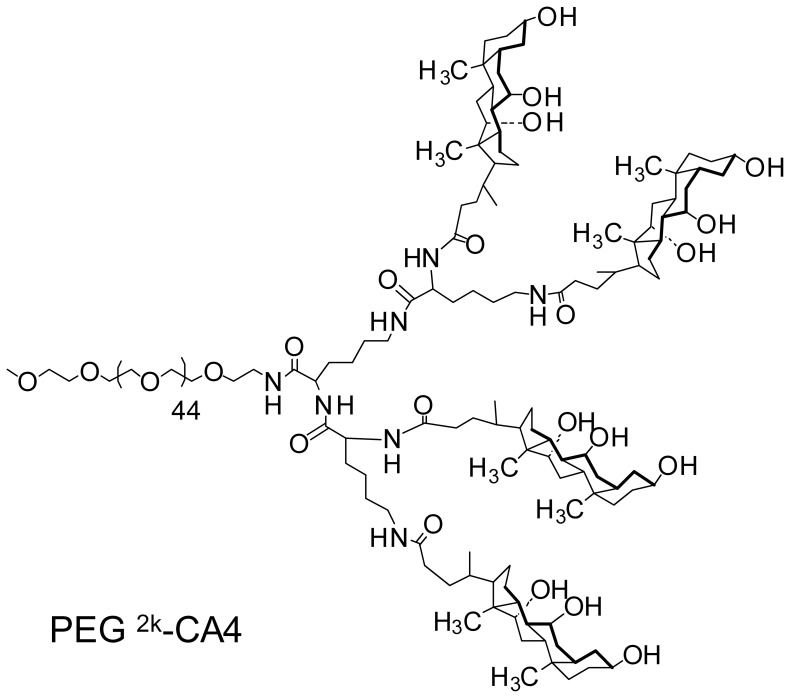
Diagram of PEG2k-CA4 telodendrimer.Boc-NH-PEG2k-CA4 telodendrimer was first synthesized using Boc-NH-PEG-NH2 (MW, 2000 Da), lysine and cholic acid as building blocks via solution phase condensation reactions. Fmoc peptide chemistry was used to couple Fmoc-Lys(Fmoc)-OH onto the unprotected amino group of PEG for three rounds to generate a third generation of dendritic polylysine.